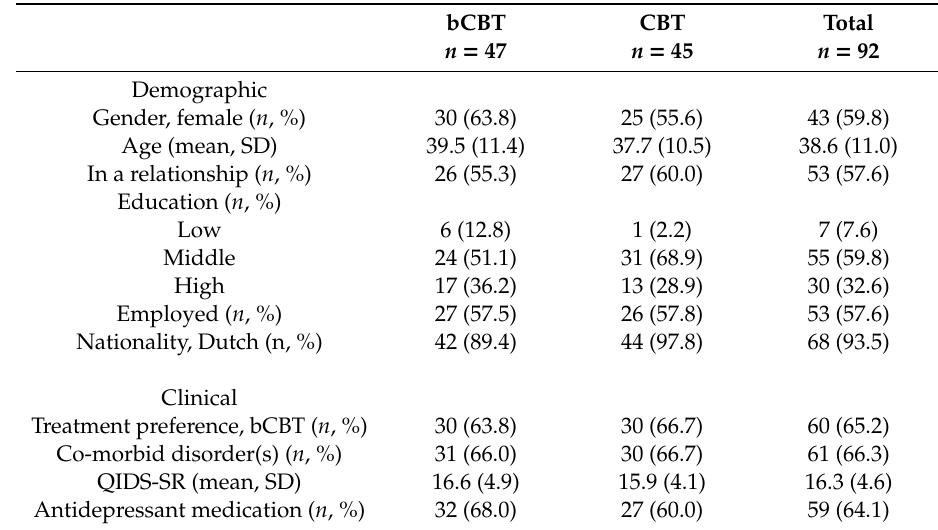
Table 1. Sample characteristics at